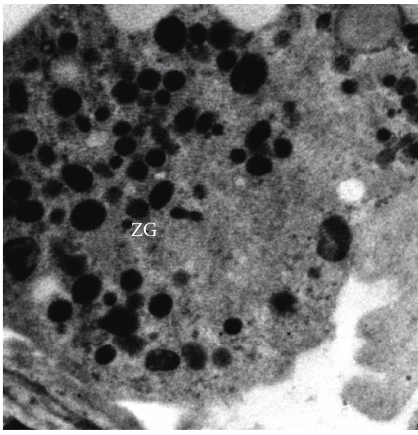
Figure 10: Electron micrograph of foetal pancreas at 48 cm CVRL (182 days) showing electron dense zymogen granules (ZG) in acinar cell × 1700.